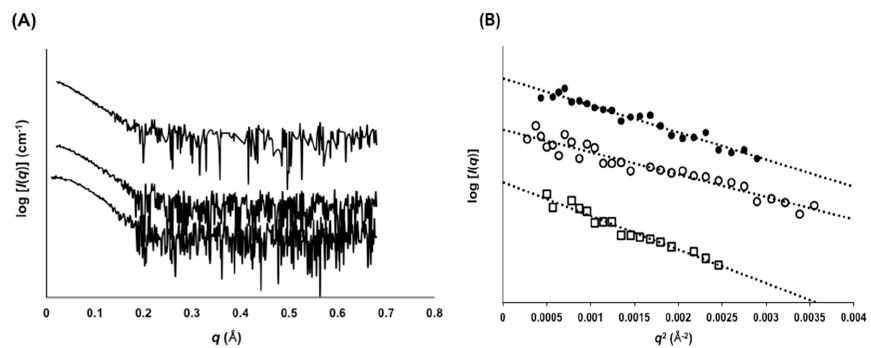
Figure 6. SAXS analysis of mutant scFvs. ( A ) Experimental SAXS curves of AGE73scFv, 73MuL-V94A, and 73MuH19 are shown from top to bottom; ( B ) The Guinier region and linear regression (dotted line) for R g evaluation. The plots represent AGE73scFv (white squares), 73MuL-V94A (black circles), and 73MuH19 (white circles), respectively.